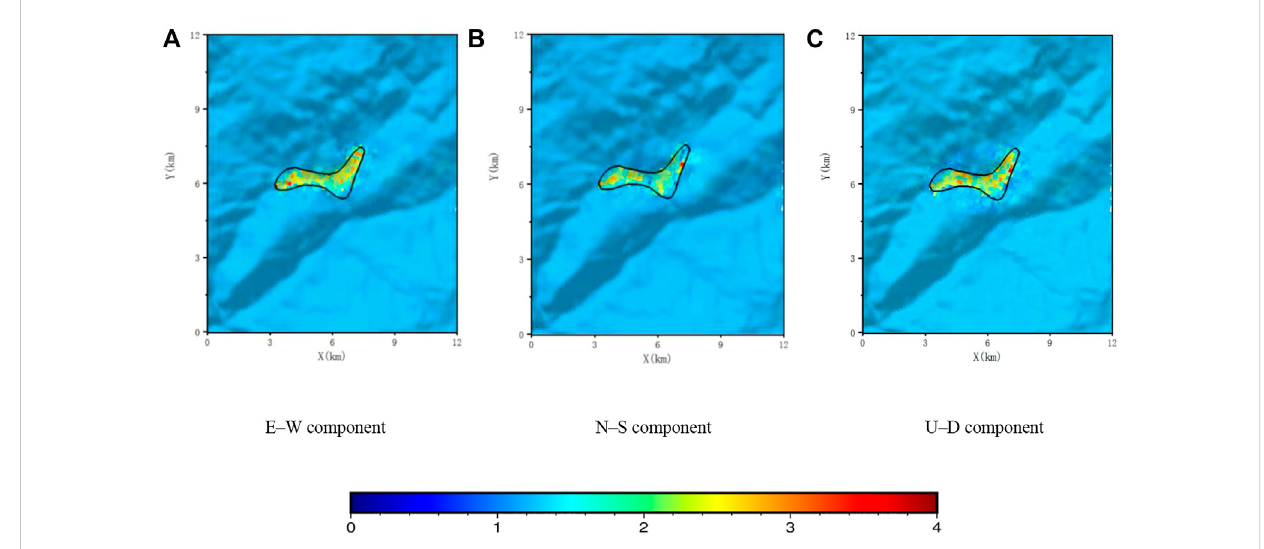
FIGURE 10 Distribution of the ampli fi cation factors of PGA (E – W, N – S, and U – D components) in the Longtoushan Town basin model compared with the bedrock site model without the basin. (A) E – W component. (B) N – S component. (C) U – D